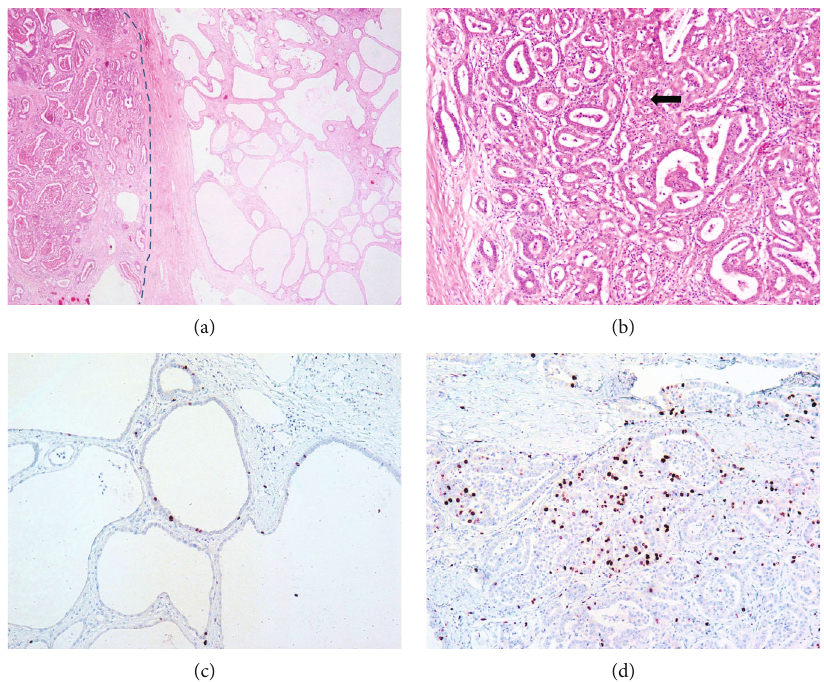
Figure 2: Histological and immunohistochemical examination of the adeno fi broma. (a) Hematoxylin and eosin-stained sections of the tumor showing cholangiocarcinoma (left side of line) and adeno fi broma with cyst formation (right side) ( × 400). (b) Adeno fi broma with complex architecture showing crowded back-to-back anastomosing and cribriform-like tubules (arrow) ( × 100). Immunohistochemical staining for Ki67 in adeno fi broma (c) and cholangiocarcinoma (d) ( ×